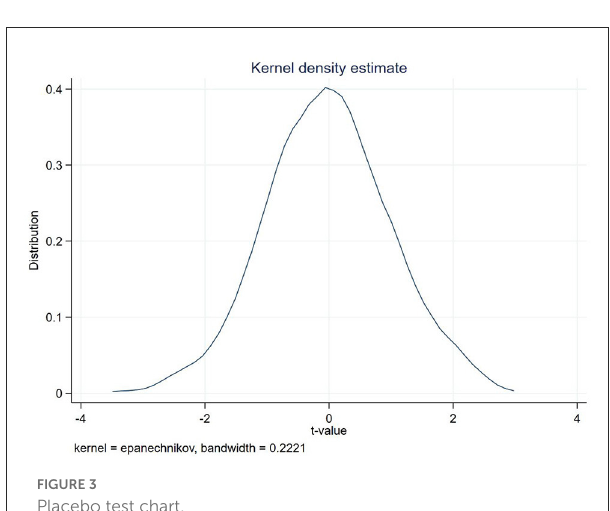
FIGURE3 Placebo test chart.